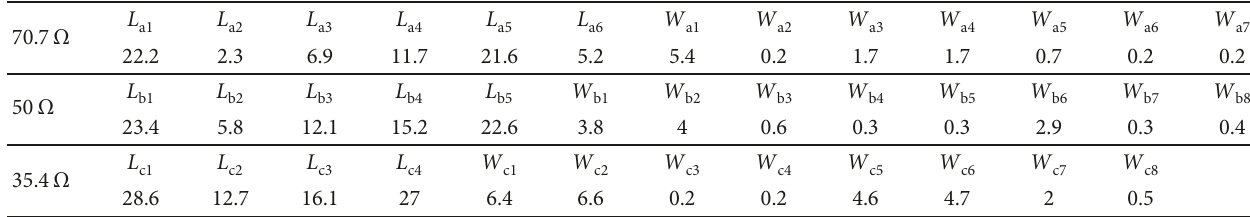
Table 2: Optimized dimensions of ATLs (unit: mm).